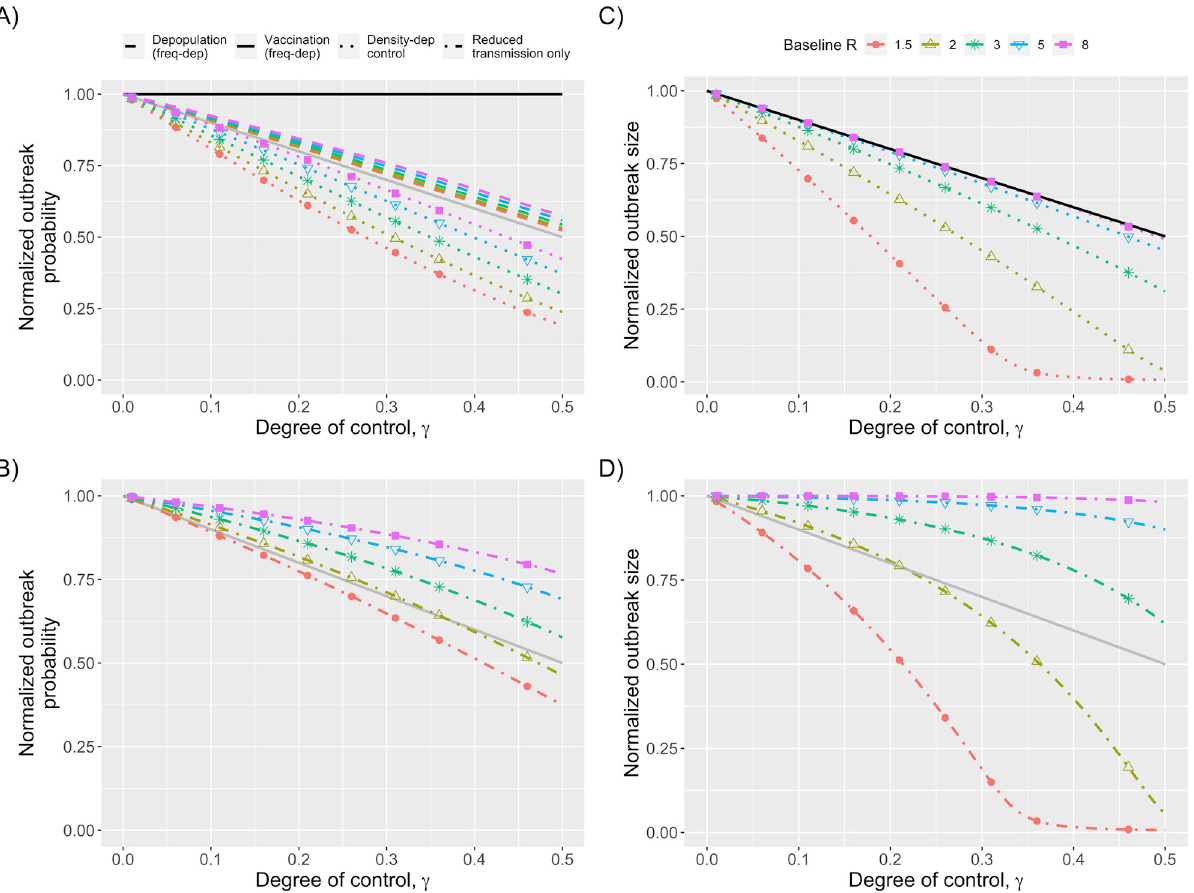
Fig 3. Probability and size of an outbreak. In panels A and B, the probability of an outbreak occurring in 100 days is shown as a function of control. In panels C and D, the expected number of cases per outbreak are shown. All panels show normalized values that are always one when there is no control. Different colors and shapes represent different values of the baseline reproduction number, R . In panels A and C, the degree of control can be B interpreted as the proportion of the susceptible population reduced by processes such as vaccination or depopulation. In panels B and D, the degree of control reflects the proportion that the baseline reproduction number is decreased. In panels A and C, the black line corresponds to frequency- dependent vaccination, which is independent of the baseline reproduction number. In panel C, the black line also corresponds to frequency-dependent depopulation. The grey line in panels A, B, and D is a visual aid to show what results would be expected if the normalized probability or output size varied in direct proportion to the degree of control. A similar grey line is absent in panel C because it overlaps directly with the black line.